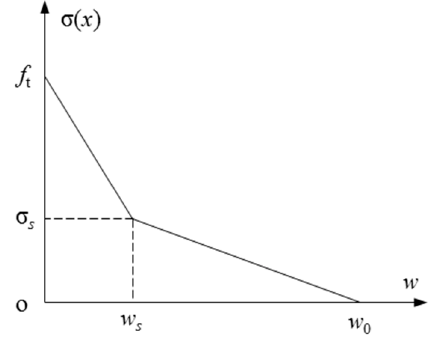
Figure 16. The bilinear softening model of the concrete.